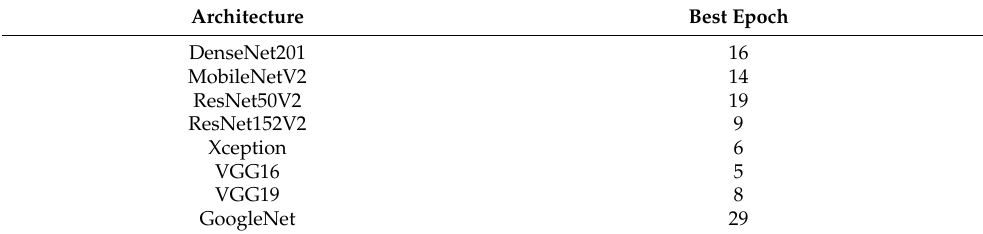
Table 5. The best epoch obtained for the architectures used in the